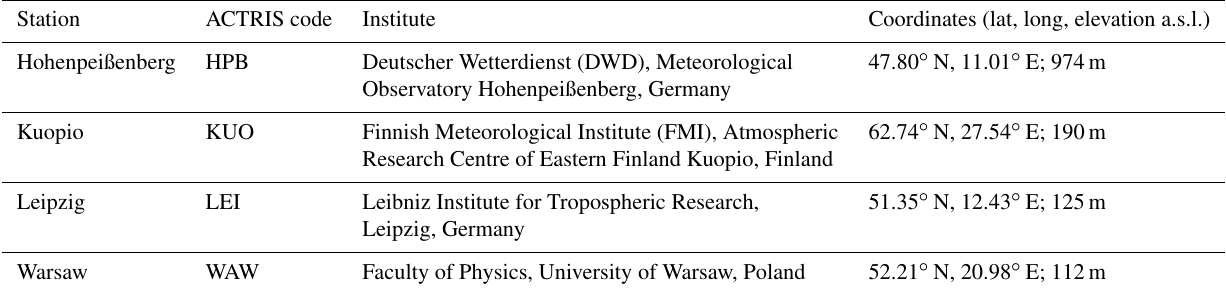
Table 1. Information of EARLINET lidar stations involved in this